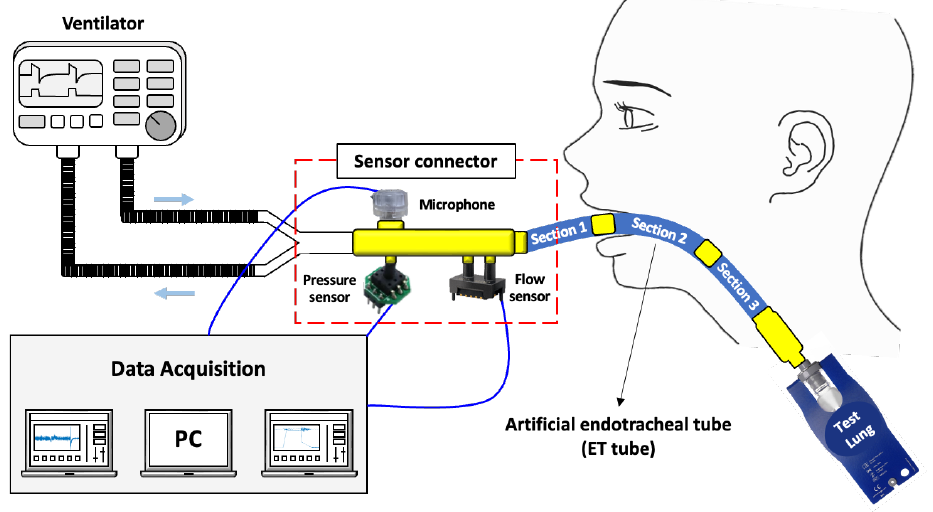
Figure 1. Overall configuration of the experiment and diagram of connection between devices.